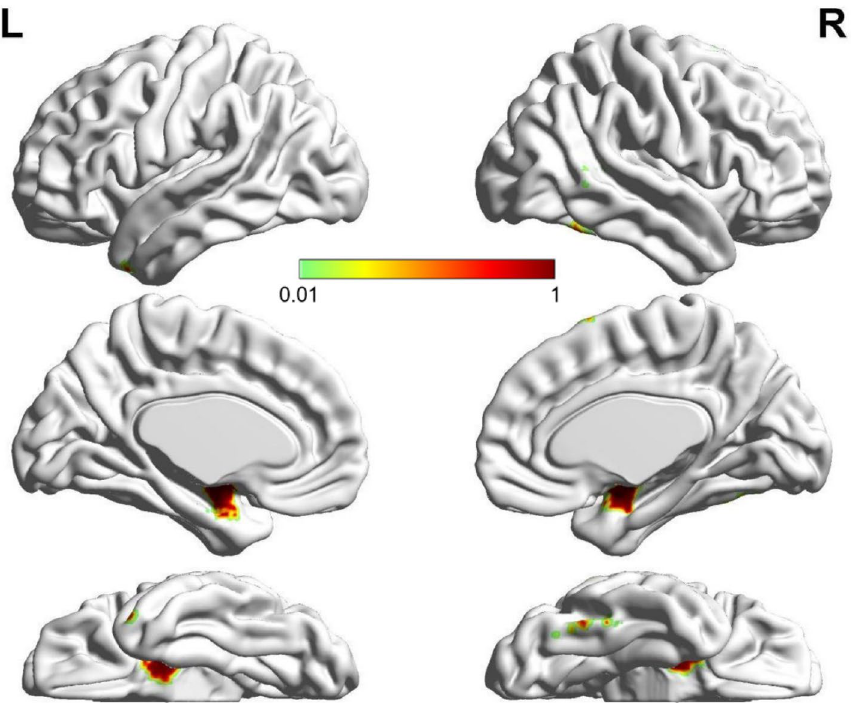
Figure 2. The lateral and medial view of brain regions related to both "emotional faces" and "facial expressions" using Neurosynth ( p < 0.01, FDR corrected, with a minimum cluster size of 10 voxels). The brain regions associated with FER obtained by using Neurosynth included bilateral AMY, bilateral HIP, right FFG and right SMA. The figure was generated by a brain region visualization tool of "BrainNet Viewer". The color bars showed the correlation between FER ability and brain regions based on meta-analysis. AMY, amygdala; HIP, hippocampus; FFG, fusiform gyrus; SMA, supplementary motor